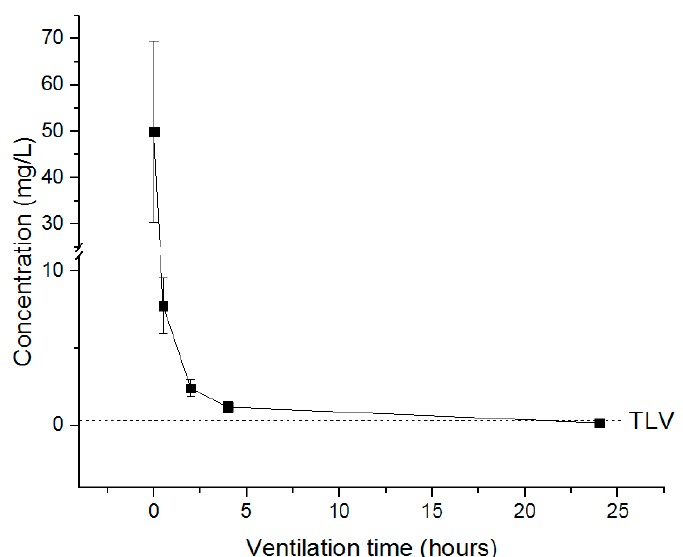
Figure 8. The concentration of EF inside the desiccator under resealed conditions. Each value represents the mean ± SE ( n = 3).